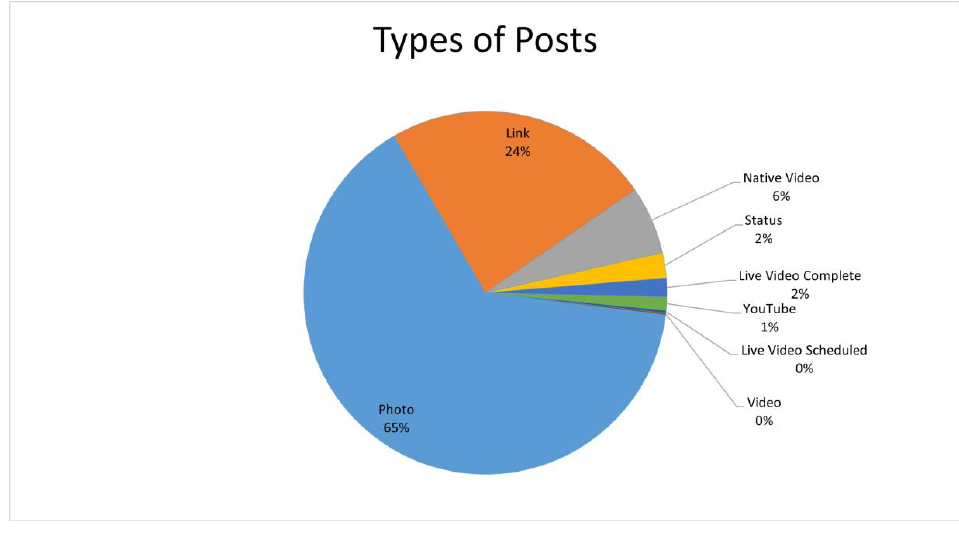
Figure 5. Types of posts on Facebook pages and groups.